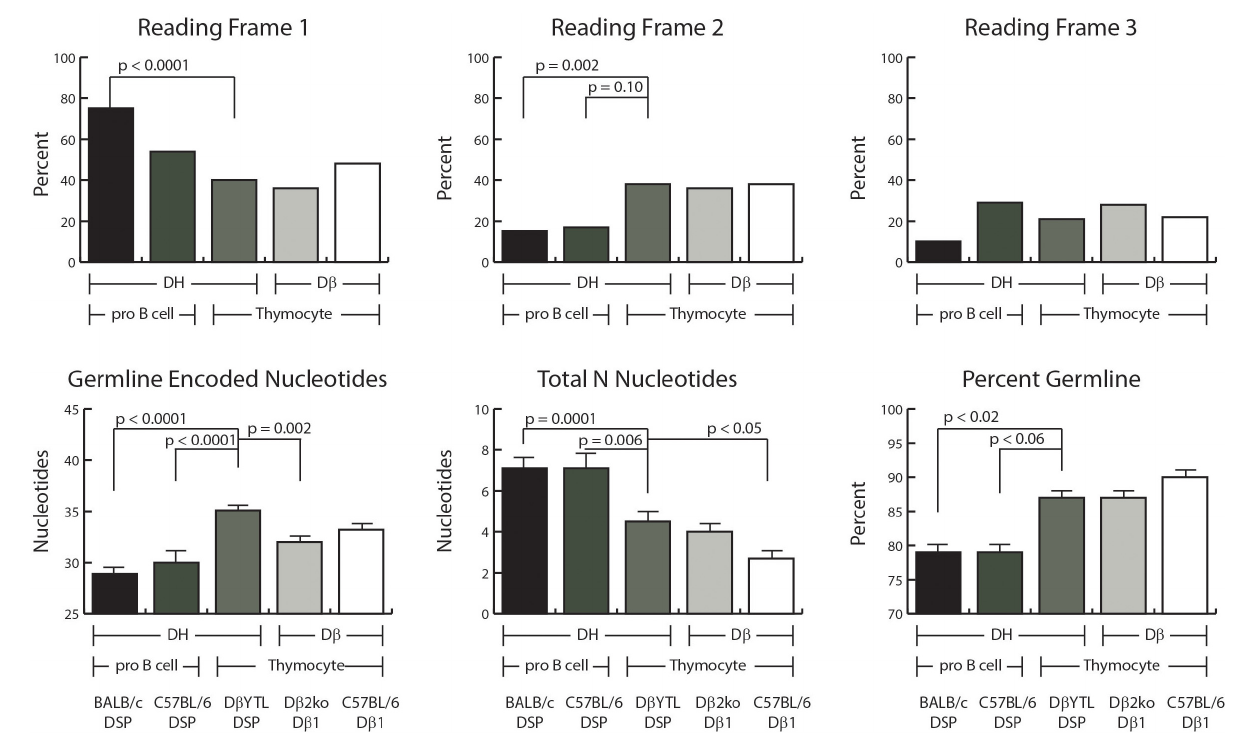
FIGURE 3 | D reading frame usage and the relative distribution of germline encoded nucleotides and N addition. Top row: the percent of sequences using the indicated reading frame. Bottom row: the average number of germline encoded nucleotides in the CDR3 interval (left) , the average number of total N nucleotides in the CDR3 interval (middle) , and the average percent of germline encoded nucleotides in each CDR3 (right) . From left to right, the first two columns of each graph represent data from Fraction B lineage cells, followed by the three columns of each graph representing data from thymocytes. Error bars display the standard error of the mean. Statistical analysis was performed only for D β YTL in comparison with the four controls, and comparisons lacking a “ p ” value all have p- values of > 0.05.